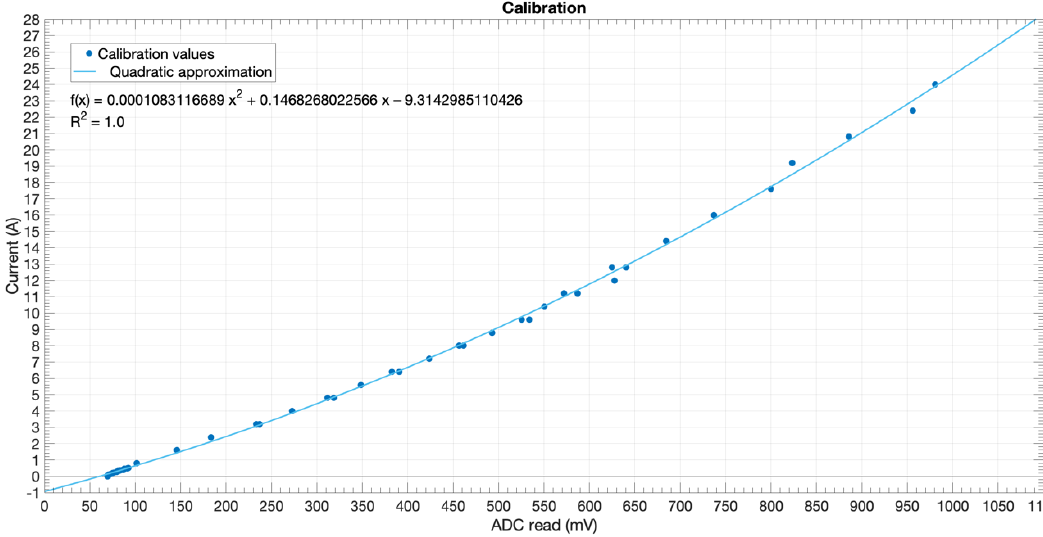
Figure 9. Calibration curve and quadratic